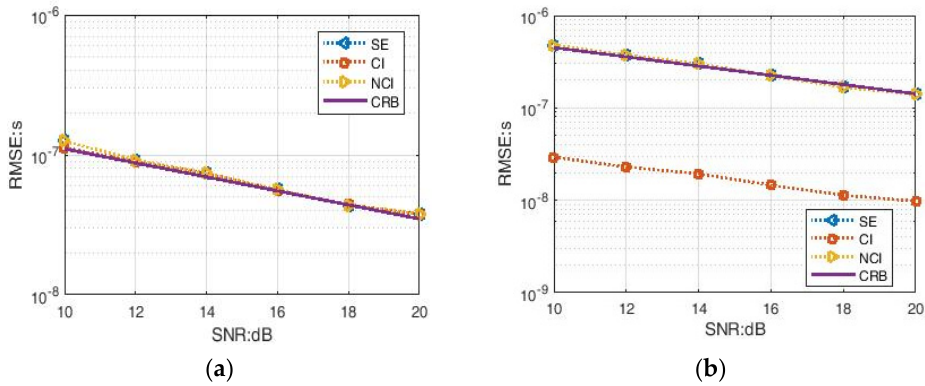
Figure 3. Estimation error accumulation probability curves of the three methods at SNR = 20 dB. ( a ) System time synchronization error estimation. ( b ) Target TDOA estimation.